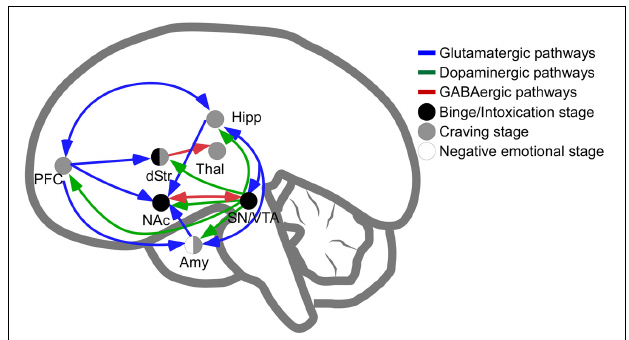
FIGURE 1 | Schematic representation of pathways involved in intoxication, withdrawal and craving stages of addiction. Release of dopamine in the nucleus accumbens is a common feature of psychostimulants reinforcement at initial stages of psychostimulants intake (dots in black are regions directly involved in binge and intoxication). The negative emotional stage of withdrawal appears to be related to the activation of amygdala (dots in white are regions directly involved in negative emotional stage) and, finally, the latter stage of psychostimulant addiction, craving, depends on prefrontal cortex, amygdala and hippocampal activities (dots in gray). In blue, glutamatergic pathways; in green, dopaminergic pathways; in red, GABAergic connections. NAc, Nucleus Accumbens; Amy, Amygdala; dStr, dorsal Striatum; Hipp, Hippocampus; PFC, Prefrontal Cortex; SN/VTA, Substantia Nigra and Ventral Tegmental Area; Thal,